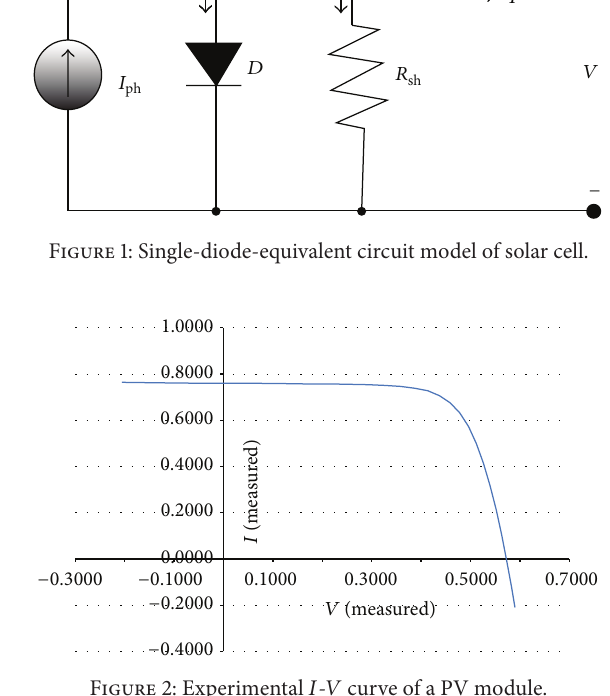
Figure 2: Experimental 𝐼 - 𝑉 curve of a PV